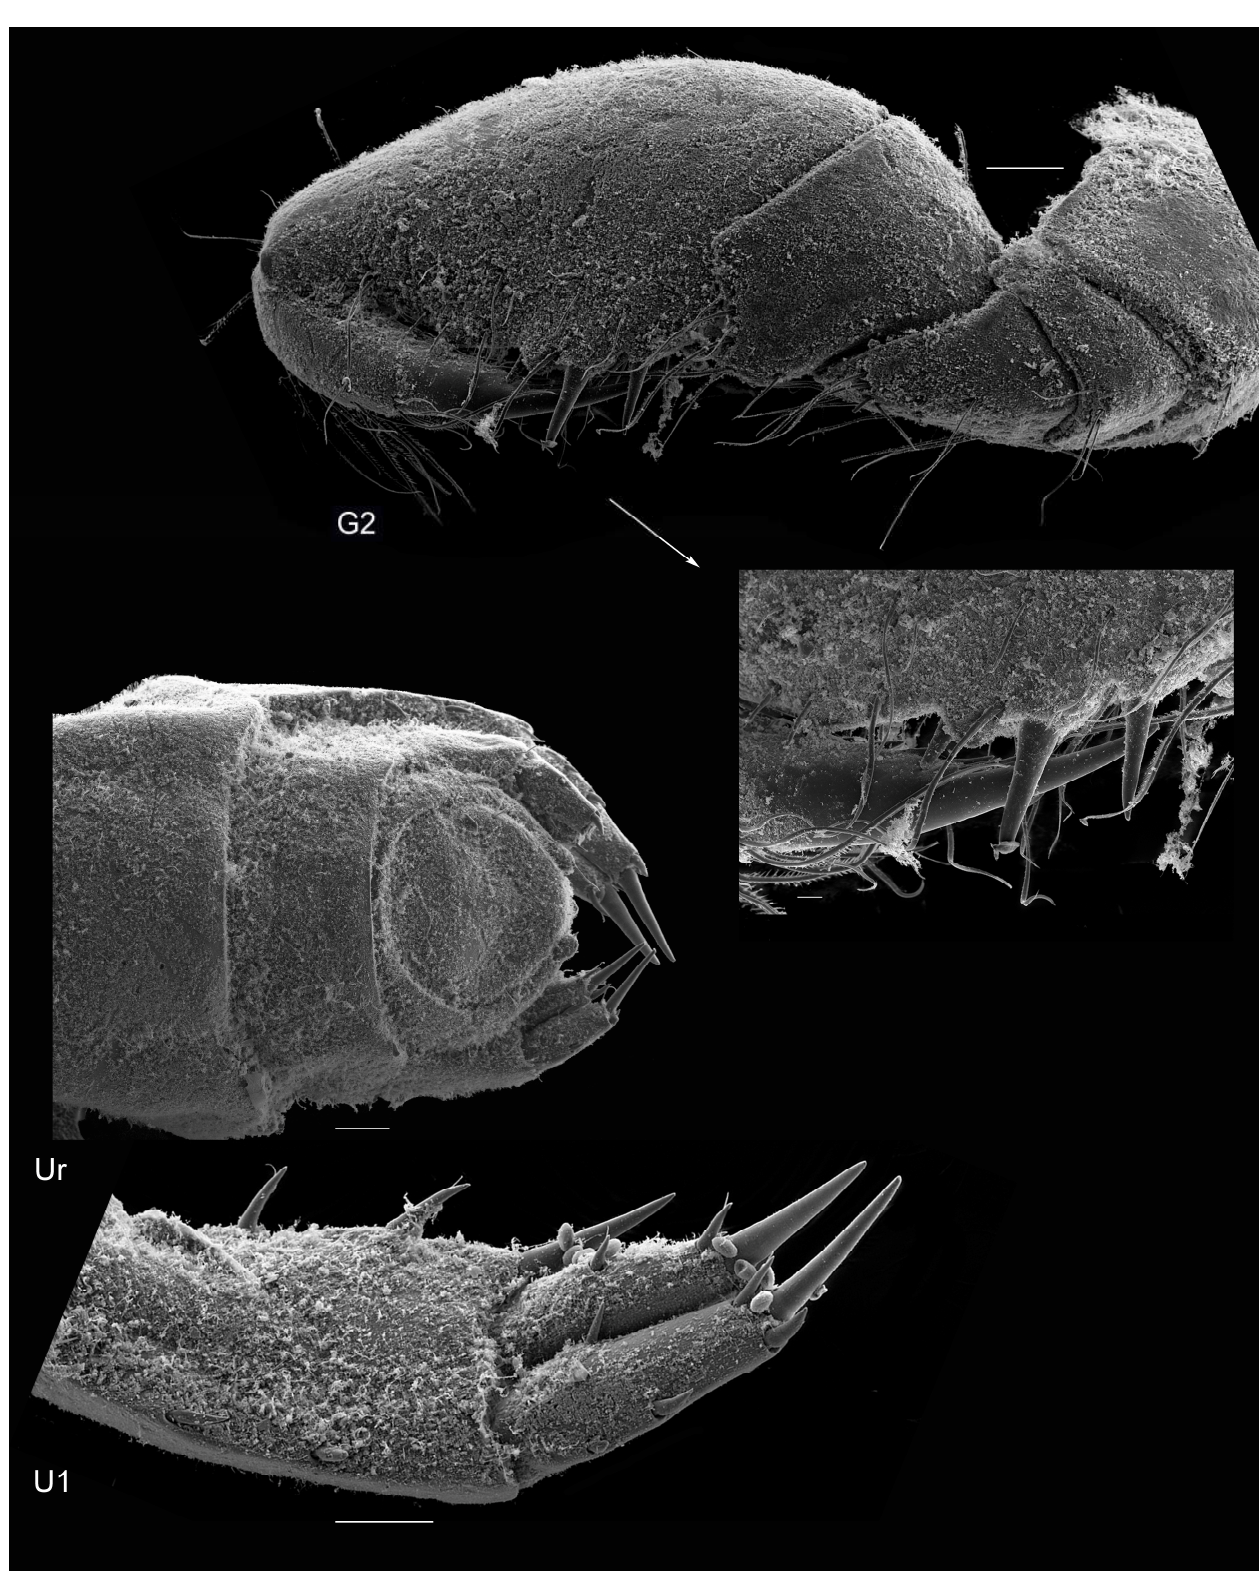
Figure 9. Unciola conchicola sp. nov. SEM image, paratype male, 7 mm, ZMHK-56724, South Island, Iceland Basin, 1921 m. Arrow pointing to detail of palm and dactylus. Scales: 100 µm, detail tip of dactylus 20 µm.